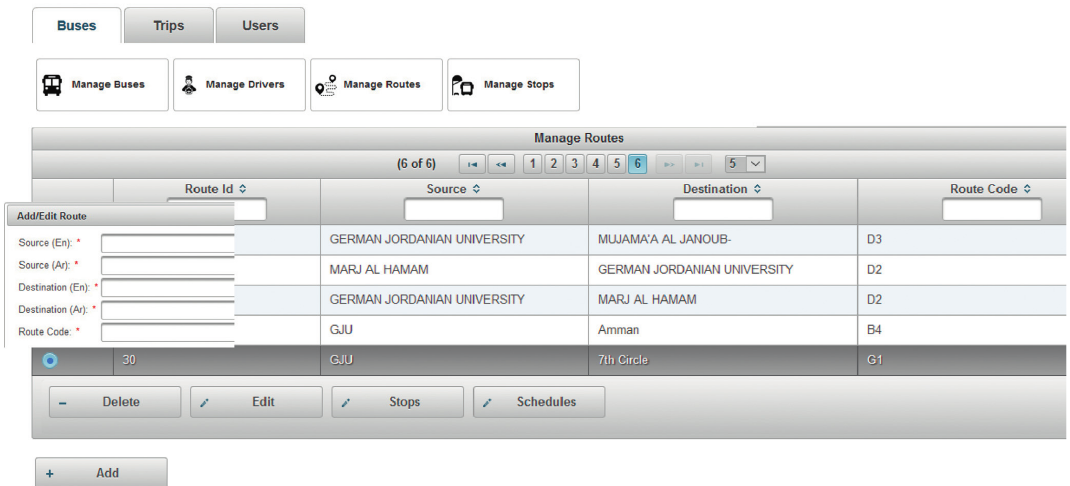
Figure 4: The manage routes screen in the admin